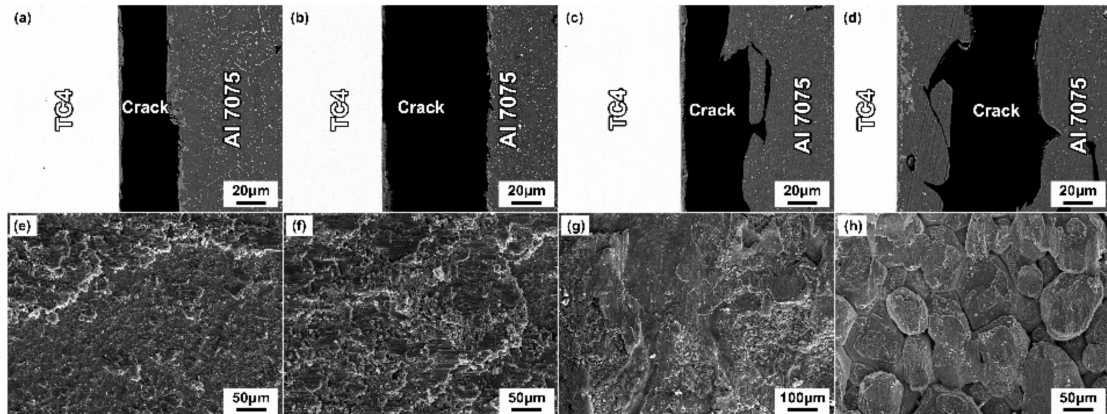
Figure 9. Fracture morphologies of TC4/Cu layer/Al7075 joints brazed at 600 ◦ C for different times. ( a , e ) 15 min; ( b , f ) 30 min; ( c , g ) 45 min; ( d , h ) 60 min.